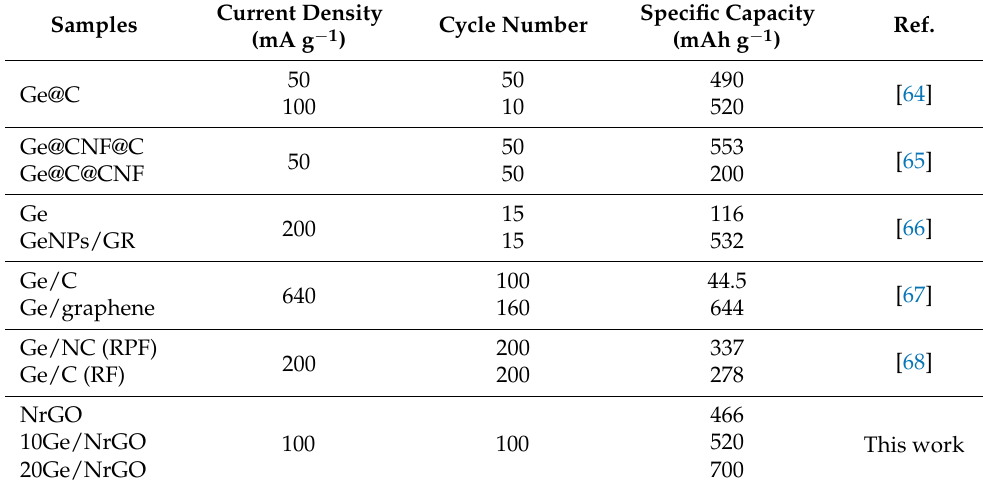
Table 2. The electrochemical performance comparison of the present work with reported Ge-based